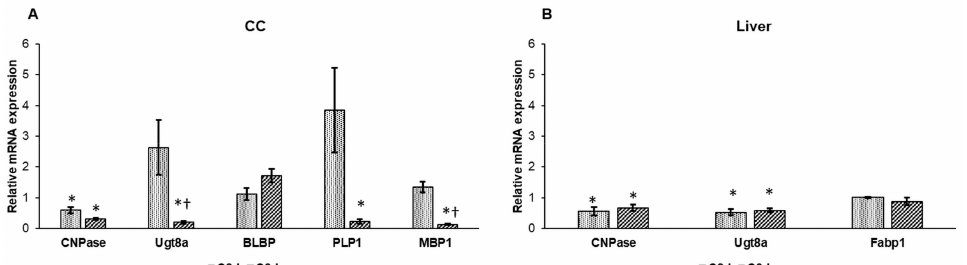
Figure 8. Relative mRNA expression levels of genes related to lipid metabolism. Real Time PCR was performed with SYBR green protocol using gene specific primers. β -actin was used as housekeeping gene for the normalization and relative expression of controls was considered as 1. ( A ) mRNA expression levels of 2 (cid:48) ,3 (cid:48) -cyclic-nucleotide 3 (cid:48) -phosphodiesterase (CNPase), ceramide galactosyltransferase (Ugt8a), fatty acid-binding protein in brain (BLBP), proteolipid protein (PLP1), and myelin basic protein (MBP1) in CC. ( B ) Relative mRNA values of CNPase, Ugt8a, and fatty acid-binding protein (Fabp1) in the liver. The columns represent mean values and the error bars represent standard errors of the mean (SEM) for three independent measurements. Student’s t -test was used to determine the statistical significances between control and treated groups. To determine the statistical significance between the treated groups a two-sample t -test was used. The asterisk marks p < 0.05 compared to non-treated animals, while the cross indicates the di ff erence p < 0.05 between the treated groups, n = 6 in each